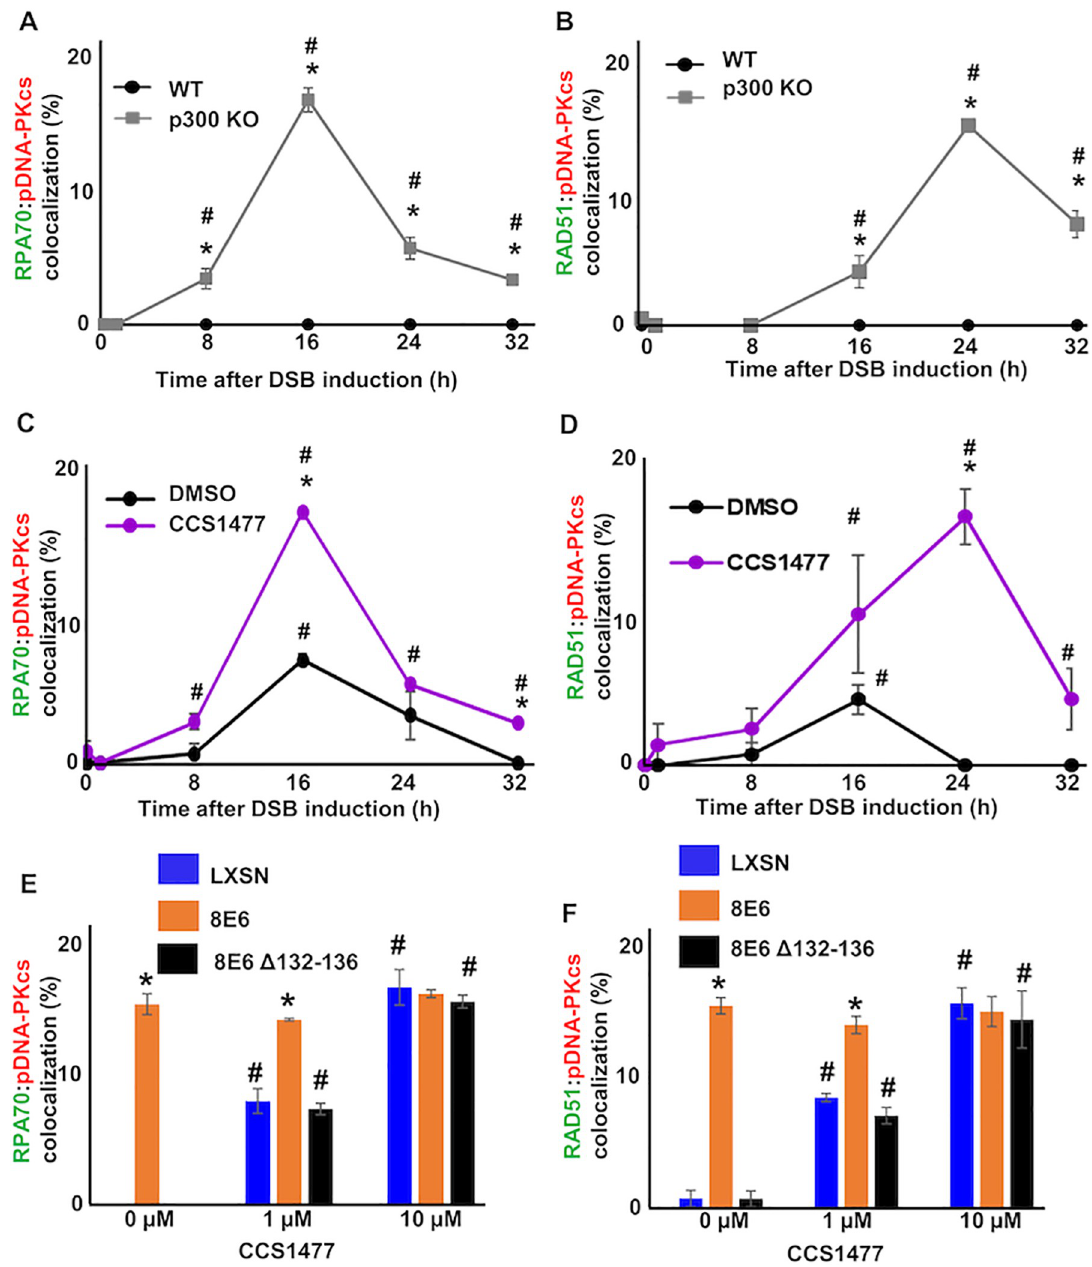
Fig 3. p300 reduces co-localization of RAD51 and RPA70 foci with pDNA-PKcs foci. (A-B) Percentage of HFK WT and p300 KO cells with (A) colocalized RPA70 (green) and pDNA-PKcs (red) foci or (B) RAD51 (green) and pDNA-PKcs (red) foci over a 32-hour time course following zeocin exposure (10 μ g/mL, 10 min). (C-D) Percentage of CCS1477 (1 μ M) or DMSO treated HFK LXSN cells that contained colocalized (C) RPA70 (green) and pDNA-PKcs (red) or (D) RAD51 (green) and pDNA-PKcs (red) foci following zeocin treatment. (E-F) Percentage of primary HFK cells treated with CCS1477 or DMSO that contained (E) colocalized RPA70 and pDNA-PKcs foci 16-hours following zeocin treatment or (F) RAD51 and pDNA-PKcs foci 24-hours following zeocin treatment. All values are represented as mean ± standard error. The statistical significance of differences between cell lines or treatments were determined using Student’s t-test. � indicates significant difference between two groups (A-D) or LXSN and 8E6 (E-F) with same treatment (p < 0.05). # indicates p < 0.05 between control (0 h) and zeocin treated group within each cell line. At least 150 cells were counted over three independent experiments.